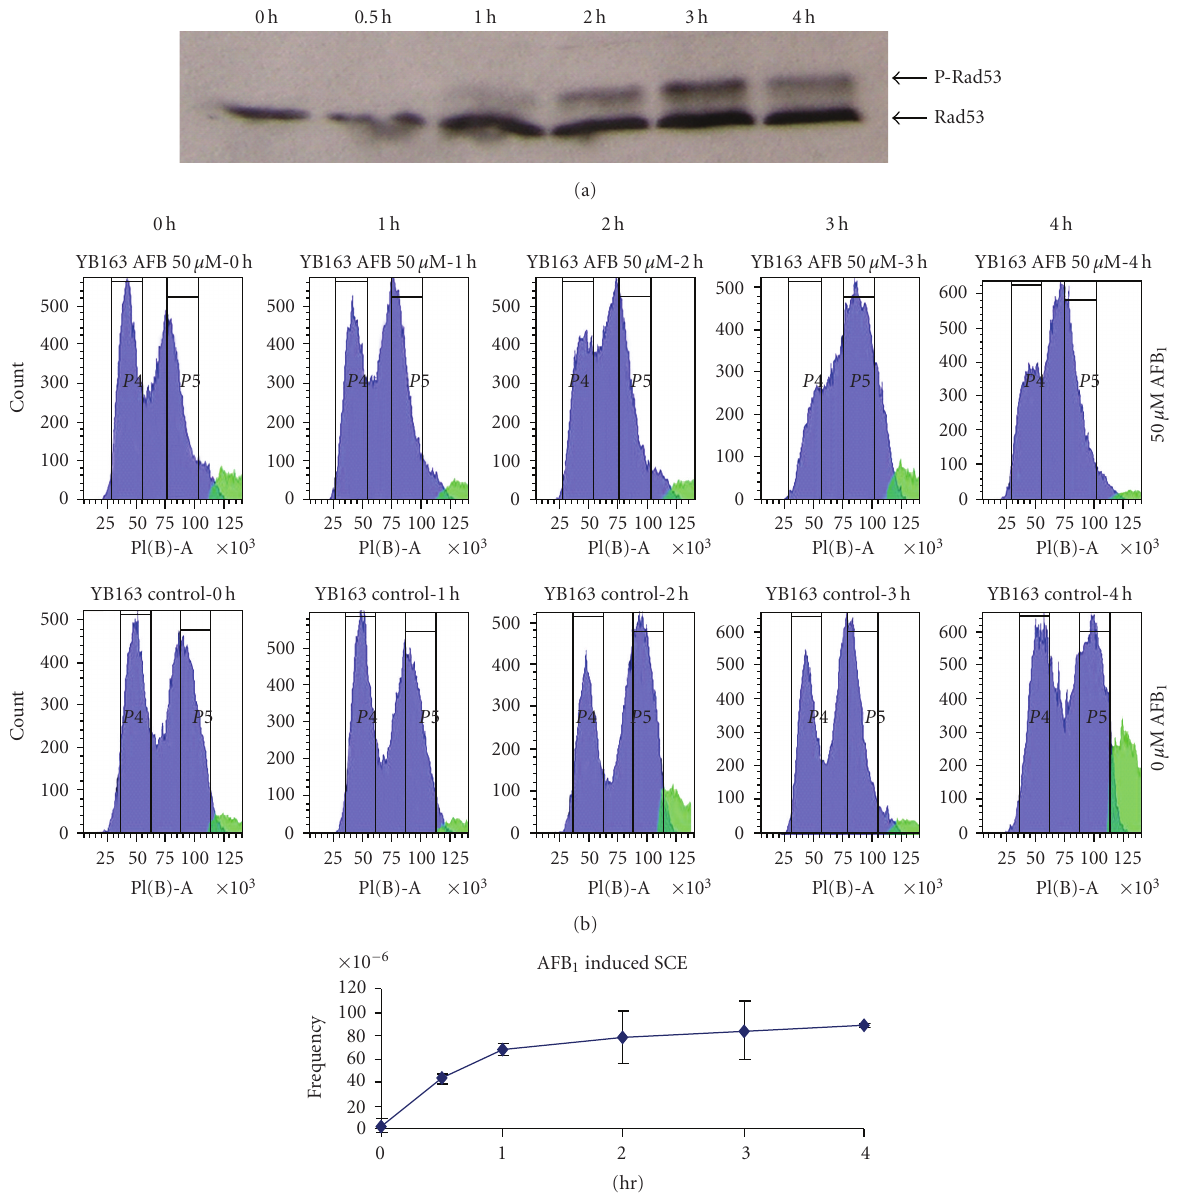
Figure 1: Rad53 checkpoint activation, cell cycle progression, and recombination after log-phase cells were exposed to 50 μ M AFB 1 . At indicated times, cells were collected for FACS analysis to measure frequencies of SCE and to make extracts to measure Rad53 activations. (a) Rad53 checkpoint activation was monitored after AFB 1 exposure at the indicated times. Rad53 and the activated checkpoint protein, Rad53p, are indicated by arrows. (b) FACS analysis was performed at indicated time periods after exposure. The G1 and G2 cells are indicated by P4 and P5. The peak to the right of the G2 peak indicates bloated cells due to enlarged vacuoles. (c) AFB 1 -associated SCE were measured by selecting for His + recombinants that result from unequal recombination between two truncated his3 fragments. Net recombination frequencies = recombination frequency after AFB 1 exposure—spontaneous recombination